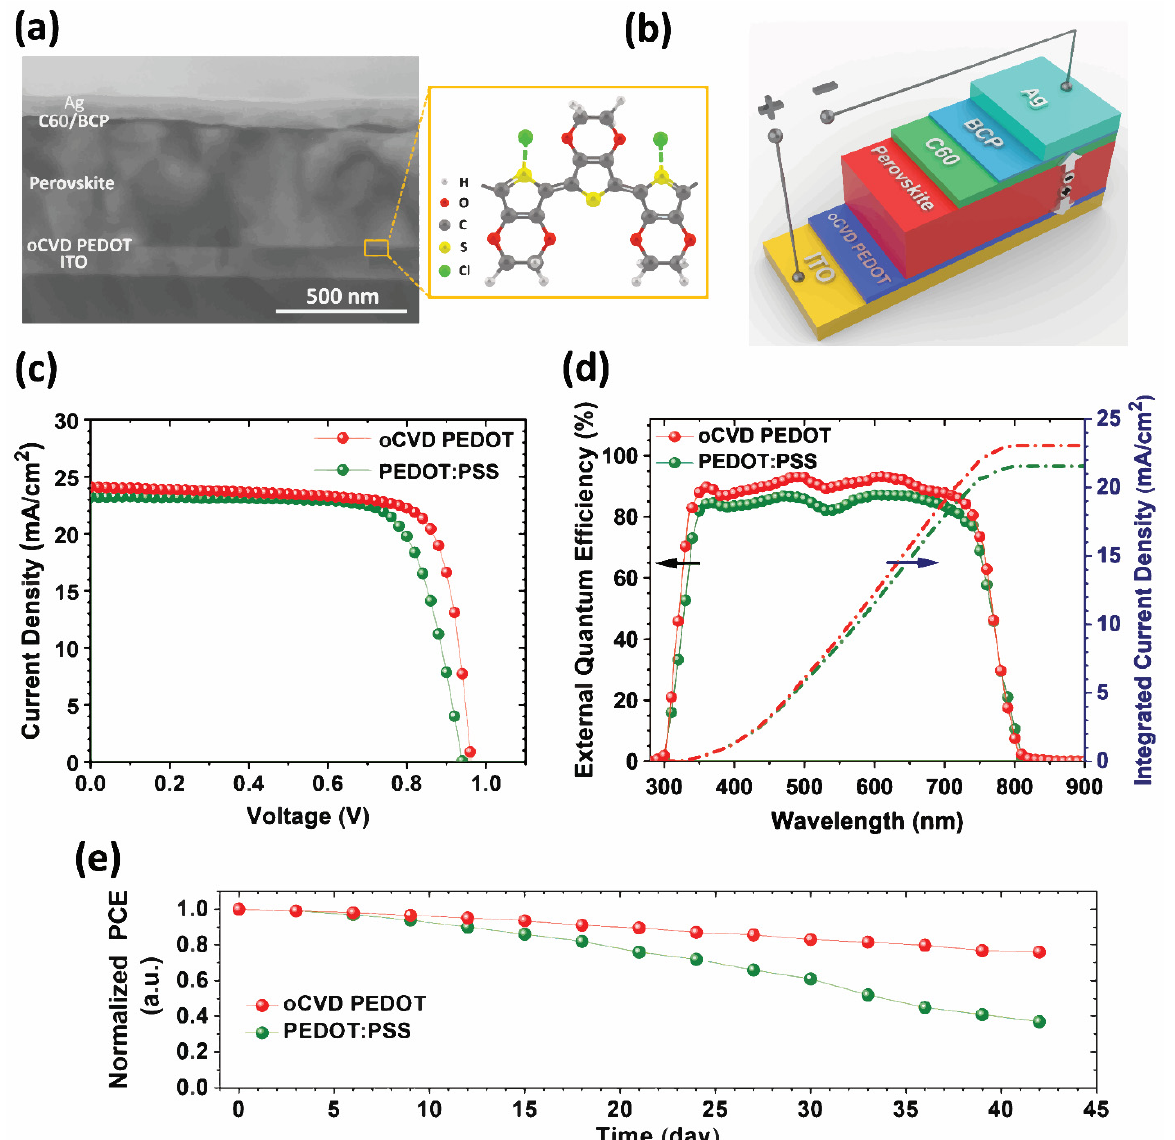
Figure 21. Photovoltaic characterization of perovskite solar cell devices with PEDOT:Cl and PEDOT:PSS [12]. ( a ) Cross-sectional SEM image and ( b ) display of the perovskite solar cell device architecture based on PEDOT:Cl as a hole transfer layer. ( c ) J-V curves and ( d ) external quantum efficiency (EQE) spectra and integrated current density of the perovskite solar cell device fabricated by PEDOT:Cl and PEDOT:PSS. ( e ) Comparison of the shelf-life stability of the inverted perovskite solar cell device with PEDOT:Cl and PEDOT:PSS. ( a – e ) Reproduced with permission [12]. Copyright 2019, Science.